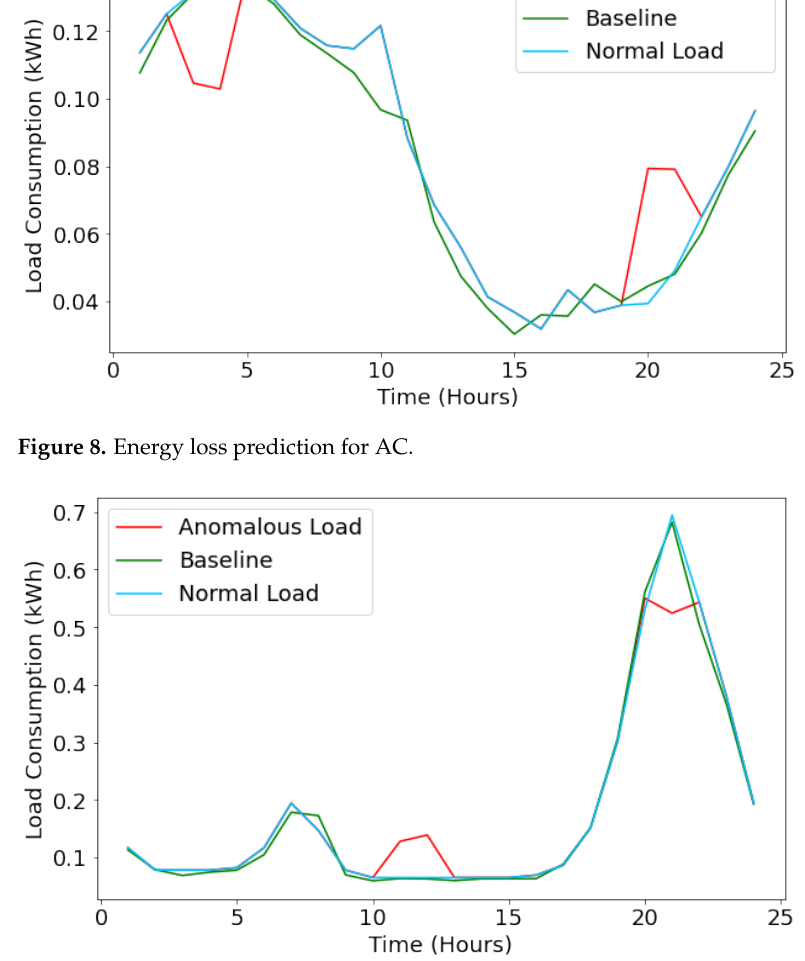
Figure 9. Energy loss prediction for